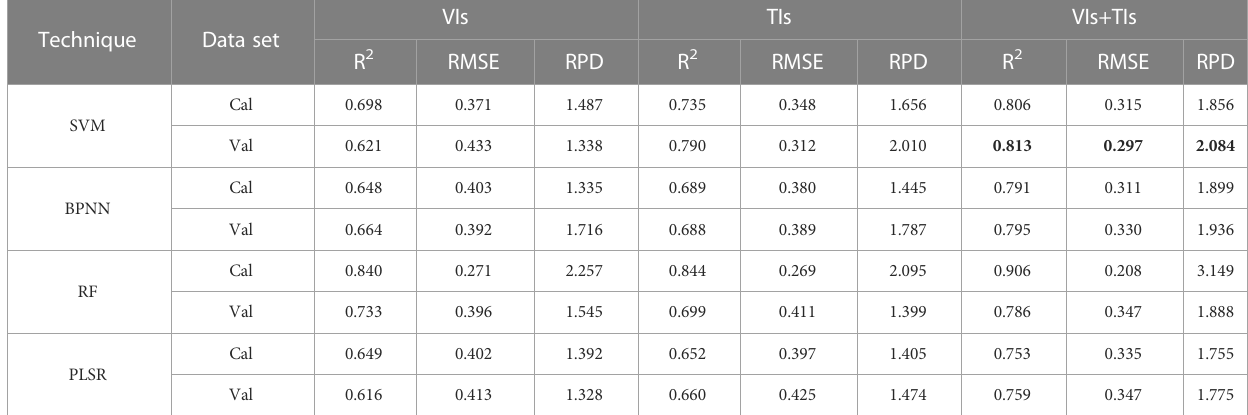
TABLE 4 Summary of the results of estimating LAI by machine learning models based on different inputs.